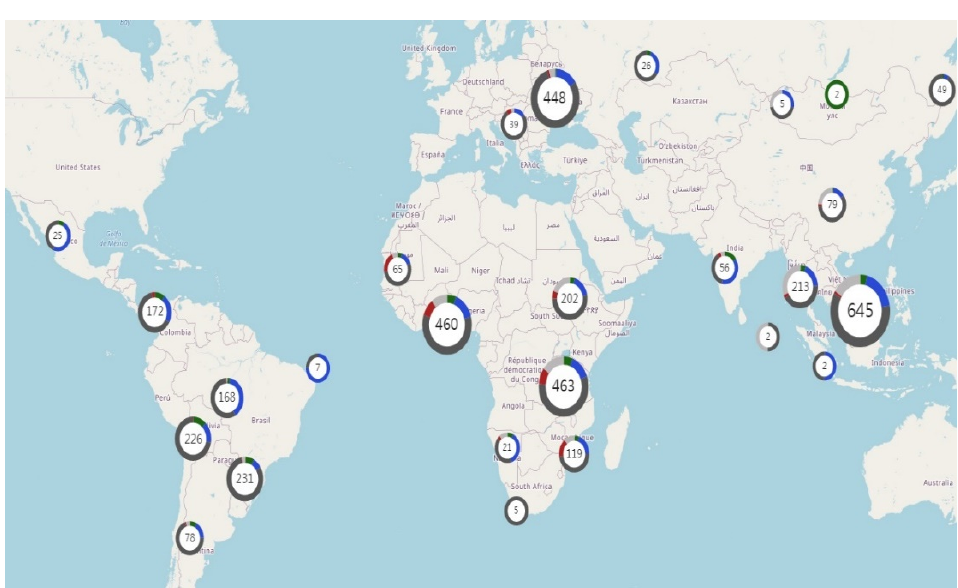
able sources in overall Community energy consumption by 2020 and a mandatory 10% minimum target to be achieved by all Member States for the share of biofuels in transport petrol and diesel consumption by 2020, to be introduced in a cost-effective way” [13] (p. 2). Further, it is stated that although it would be possible for them to meet the target of using renewable energy in transport from domestic production, “it is both likely and de- sirable that the target will in fact be met through a combination of domestic production and import” [13] (p.3). Accordingly, many investors found it as an opportunity to invest in biofuel production. The African continent, especially the southern region, became a great target for investors due to the continent’s low population density, reasonable climate and soil conditions, and underutilized land [14]. Consequently, many foreign investors went to Africa to produce agrofuels for export to the EU and contributed to land grabbing in the continent [15,16]. In fact, global land grabbing, not only applicable to the African continent, is often referred to as the explosion of transnational commercial land transactions and land spec- ulation around the large-scale production and export of biofuels and food [17]. It concerns national governments and private investors in financially rich but resource poor countries to use financially poor but resource rich countries to secure their own food and energy [9], dispossessing peasants and indigenous people and ruining the environment in the South [17]. In other words, land grabbing can be interpreted as an action “driven by global cap- ital accumulation dynamics and strategies in response to crises concerning finance, envi- ronment, energy and food” [18] (p. 1559). However, it would be insufficient to conclude that land grabbing in Africa is solely about the Global North grabbing land in the continent. In Africa, more land grabbing in- cidences occur in countries where governance is weak. These African governments take advantage of weak land tenure systems in their own countries and reallocate land to for- eign government and investors, particularly for agricultural development in order to bal- ance their budgets [10]. As mentioned earlier, most land grabbing cases in Malawi have occurred on custom- ary land. The factor driving this is the inherent problems of the customary land tenure